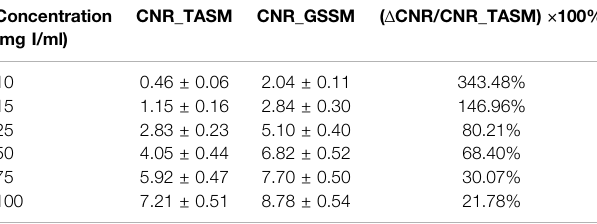
TABLE 5 | Quantitative analysis of CNR for different concentrations. Concentration (mg